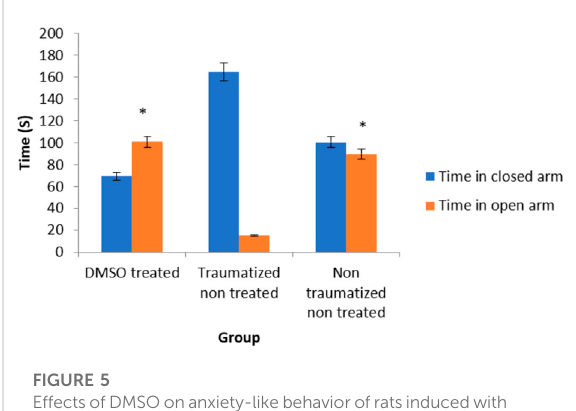
FIGURE 6 Effects of DMSO on the brain cortex concentration of S100